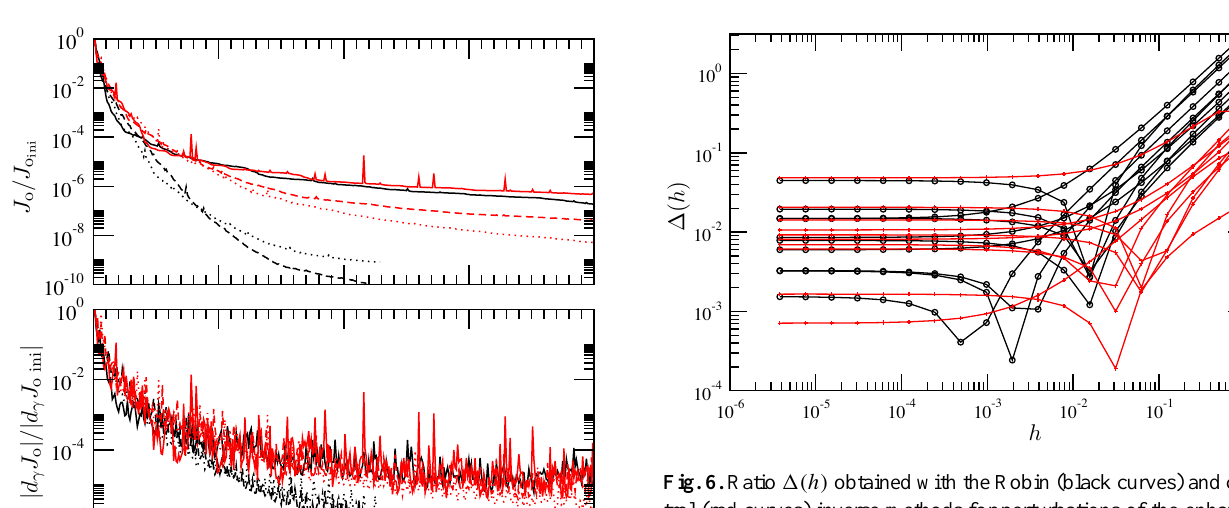
Iterations Fig. 5. Evolution as a function of the number of iterations of (top) the cost function relative to the initial cost function and (bottom) the norm of the gradient vector relative to the initial gradient norm for the Robin (black curves) and Control (red curves) inverse methods for the inversion of β (solid curve), E η ( x,y ) (dashed curve) and E η ( x,y,z ) (dotted curve).